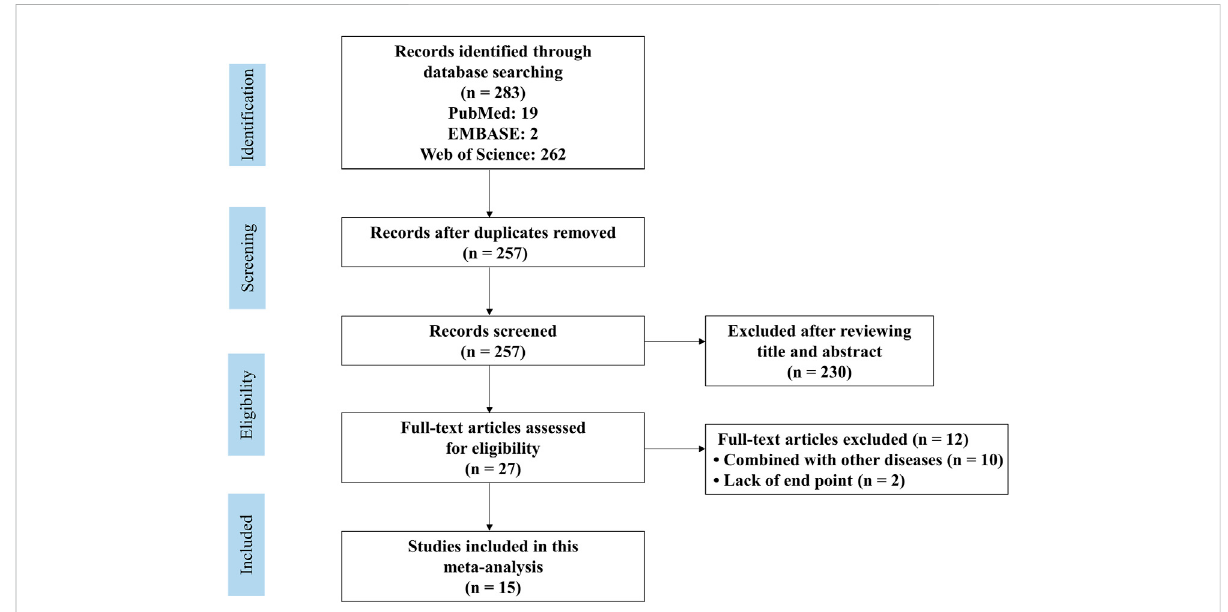
FIGURE 1 PRISMA fl ow diagram for review and selection process of studies included in meta-analysis of metformin in rodent models of